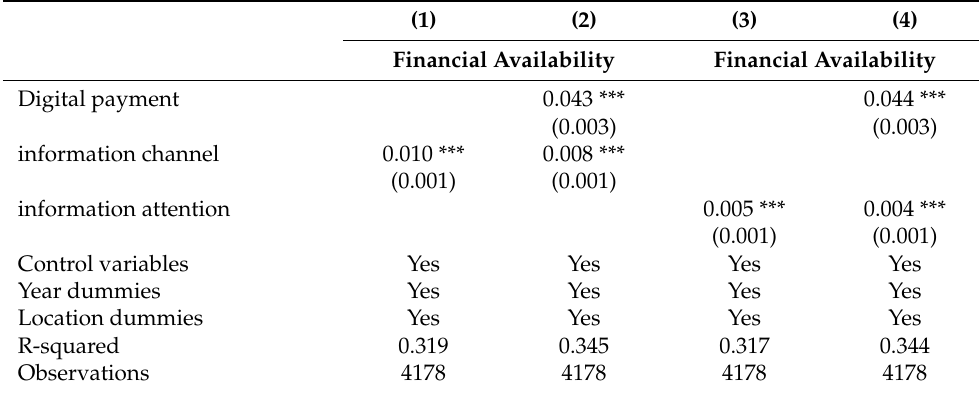
Table 11. Digital payment adoption, information effects and financial availability (estimated by OLS